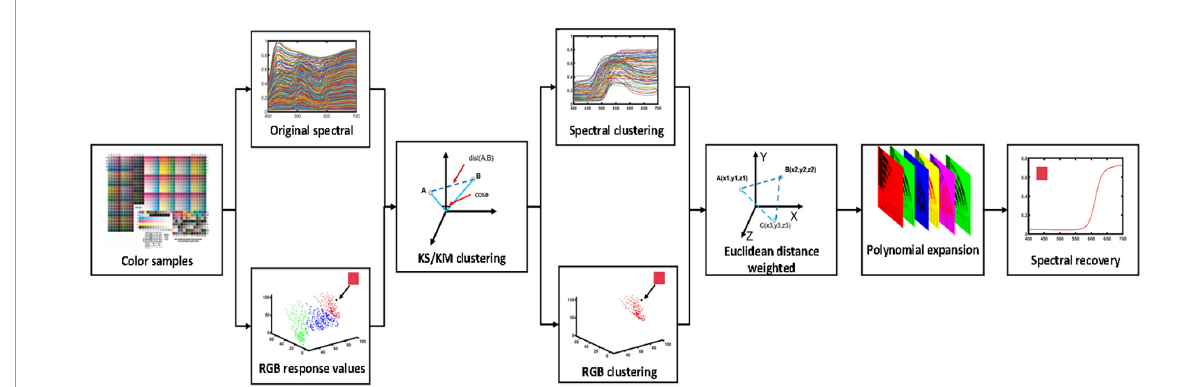
FIGURE1 Schematic illustration of the optimized clustering method for spectral reflectance recovery.